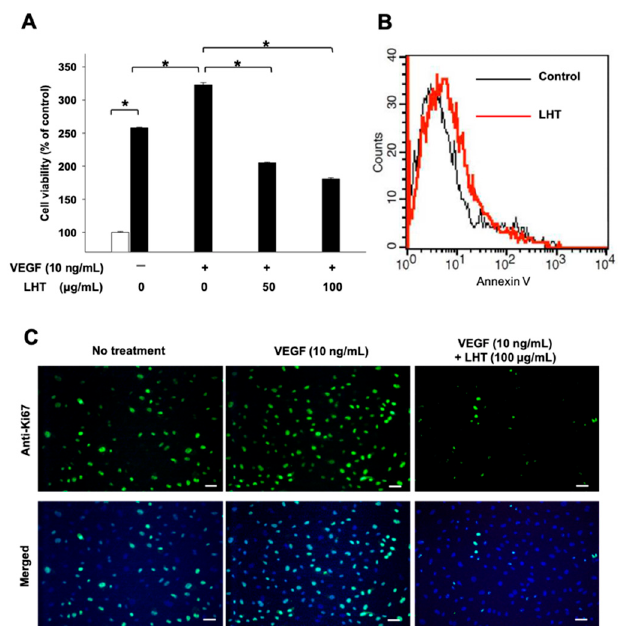
Figure 3. Inhibition of VEGF-induced proliferation of the human umbilical vein endothelial cells (HUVECs) after cultivation with LHT. ( A ) The viability of HUVECs after cultivation with different concentrations (0, 50, 100 µg/mL) of LHT plus VEGF (10 ng/mL) for 48 h. For control groups, the viability of HUVECs was measured after cell seeding or after 48 h of cultivation without anything. Data were expressed with mean ± s.e.m. (n = 5). * p < 0.05 at each comparison. ( B ) Flow cytometry analysis of HUVECs using PE Annexin V Apoptosis Detection Kits (triplicate) after treatment of LHT (100 µg/mL) for 48 h. Black line: no treatment of LHT. Red line: LHT treatment for 48 h. ( C ) Anti-Ki67 immunostaining of HUVECs without or with VEGF (10 ng/mL) and LHT (100 µg/mL). Blue: DAPI; Green: Anti-Ki67. Scale bars indicate 100 µm.